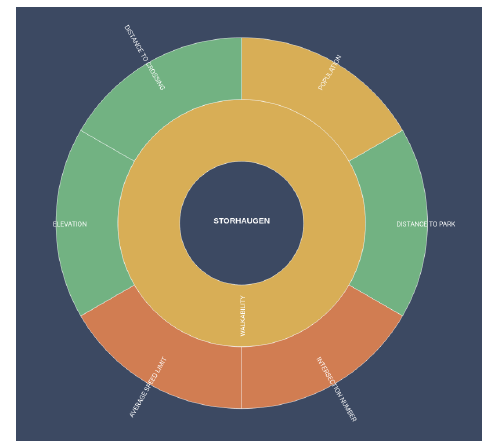
Figure 14. Diagram of Storhaugen, ˚Alesund, Norway.